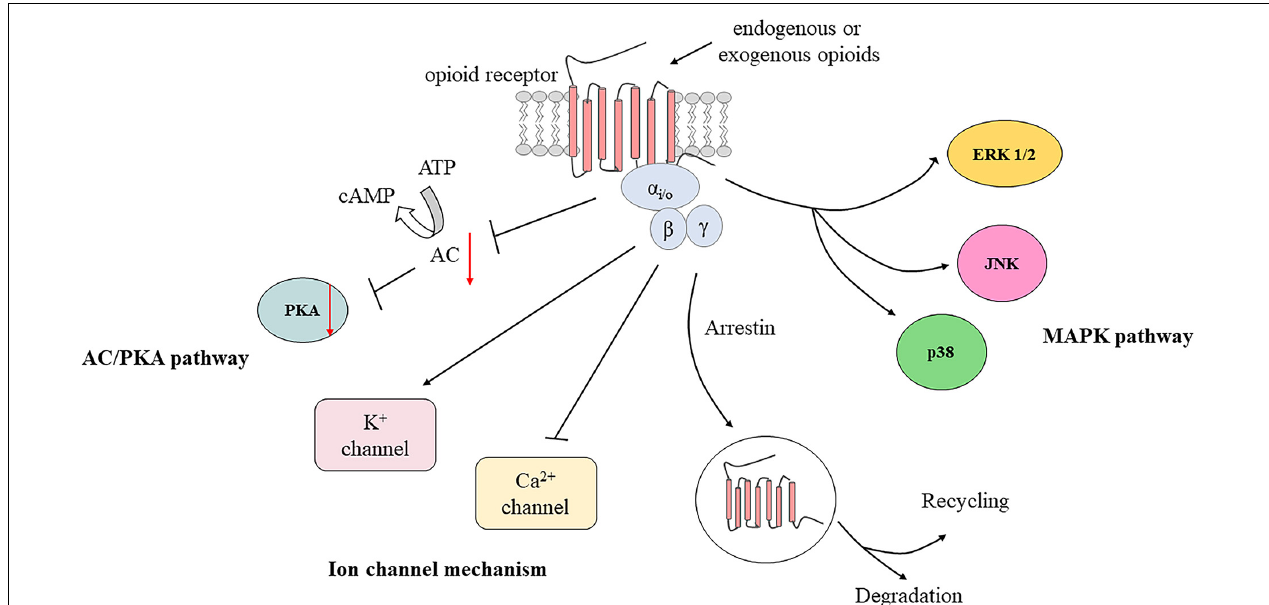
FIGURE 2 | Activation of peripheral opioid receptors by endogenous and exogenous opioids. AC, adenylyl cyclase; cAMP, cyclic adenosine monophosphate; PKA, protein kinase A; ERK 1/2, extracellular signal regulated kinase 1 and 2; JNK, c-Jun N-terminal kinase; MAPK, mitogen-activated protein